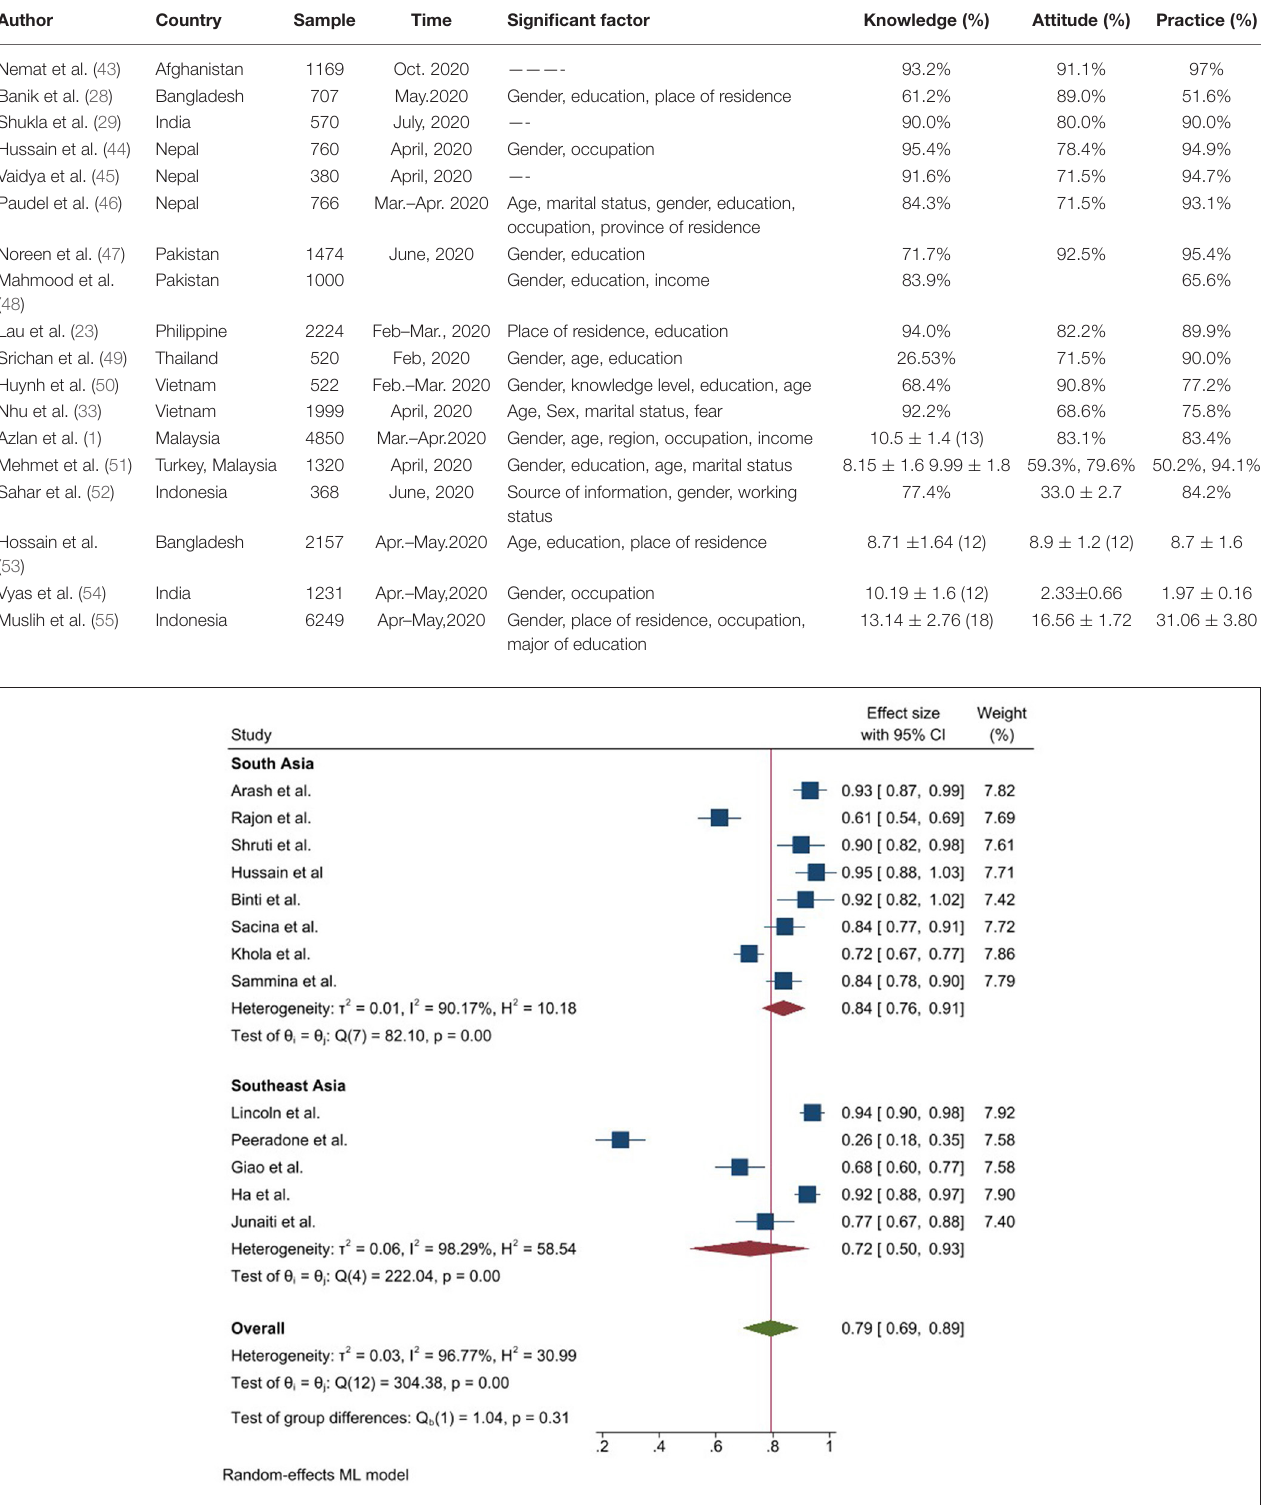
TABLE 4 | Characteristics of studies included in the systematic review of knowledge, attitude and practice toward COVID − 19 in Southeast and South Asia.